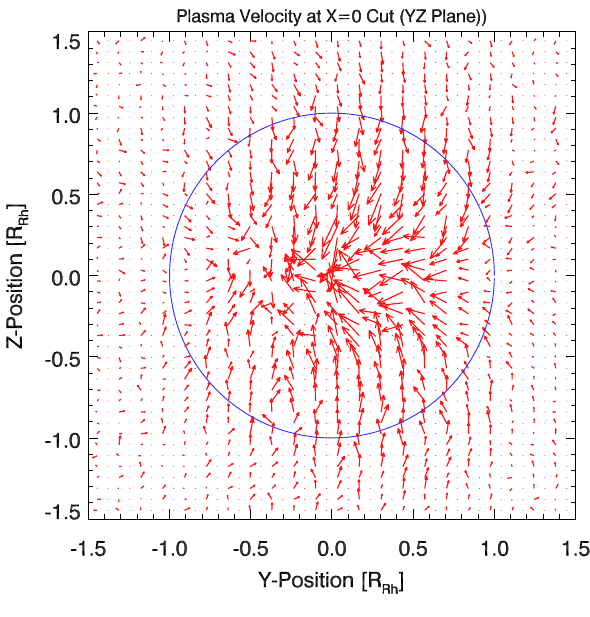
Fig. 7. Perturbations of v y and v z in an yz-cut just behind Rhea. The expansion of the plasma velocity inside the cavity is clearly seen. The peak amplitude of the v y or v z components is about 30 km s − 1 .